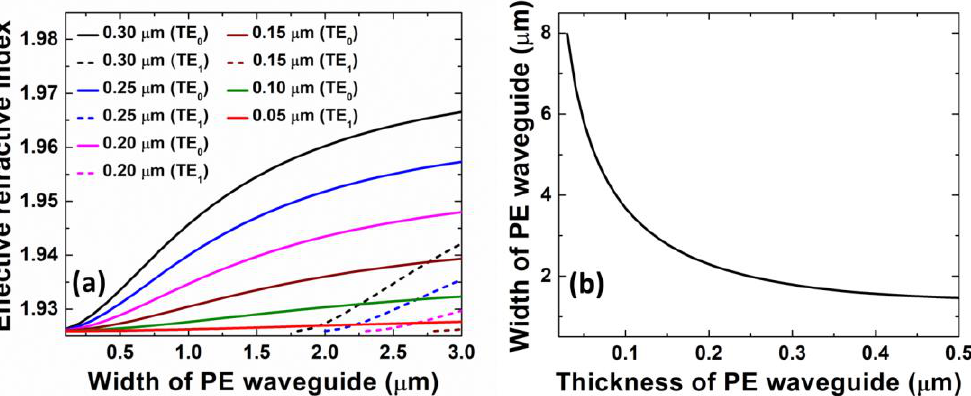
Figure 2. (a) Effective indices of the transverse electric (TE) modes in the proton exchange (PE) waveguides as a function of the width for different thicknesses of the PE waveguides. (b) Cut-off dimensions of the PE region for the TE mode.